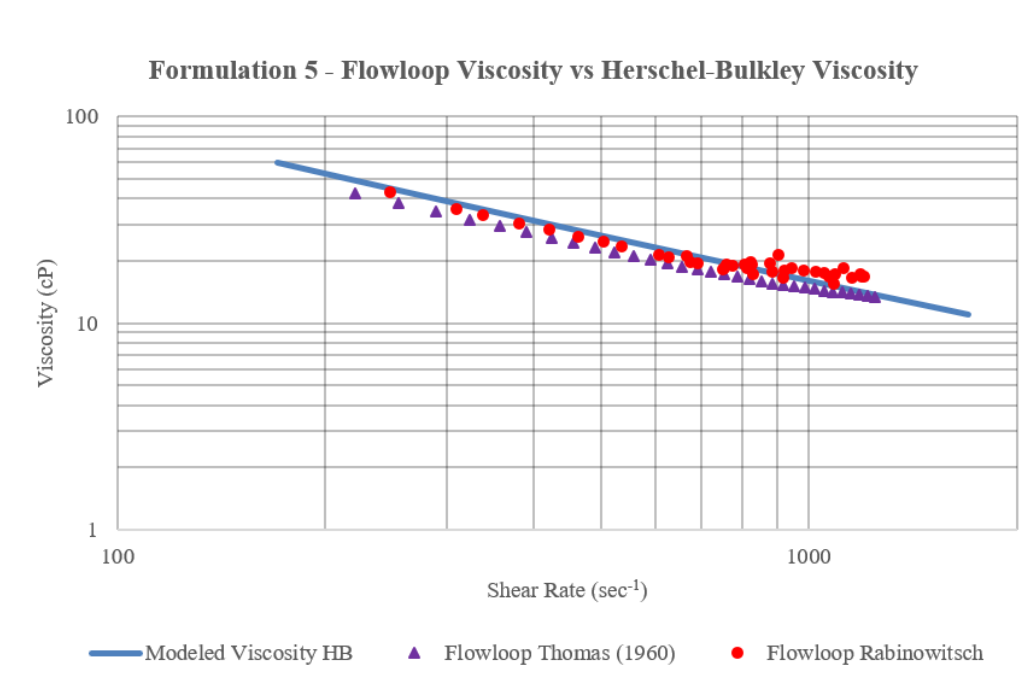
Figure 10: Estimated viscosity of Formulation